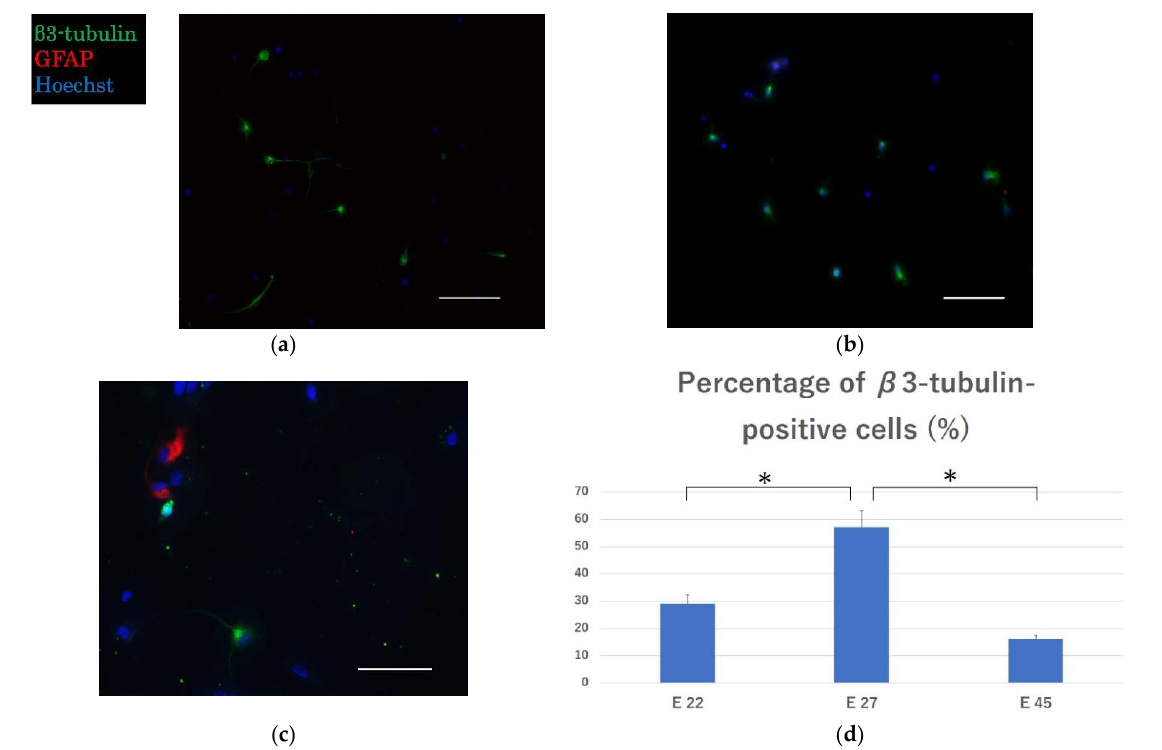
Figure 1. Cultured embryonic spinal cord cells from different ages. Representative image of ( a ) cells from a 22-day embryo; ( b ) cells from a 27-day embryo; ( c ) cells from a 45-day embryo; ( d ) percentage of β3-tubulin positive cells in E 22, E 27 and E 45 groups. GFAP, glial fibrillary acidic protein. Scale bar = 60 µm. * p < 0.05 between groups. The data are presented as mean ± standard error (SE).